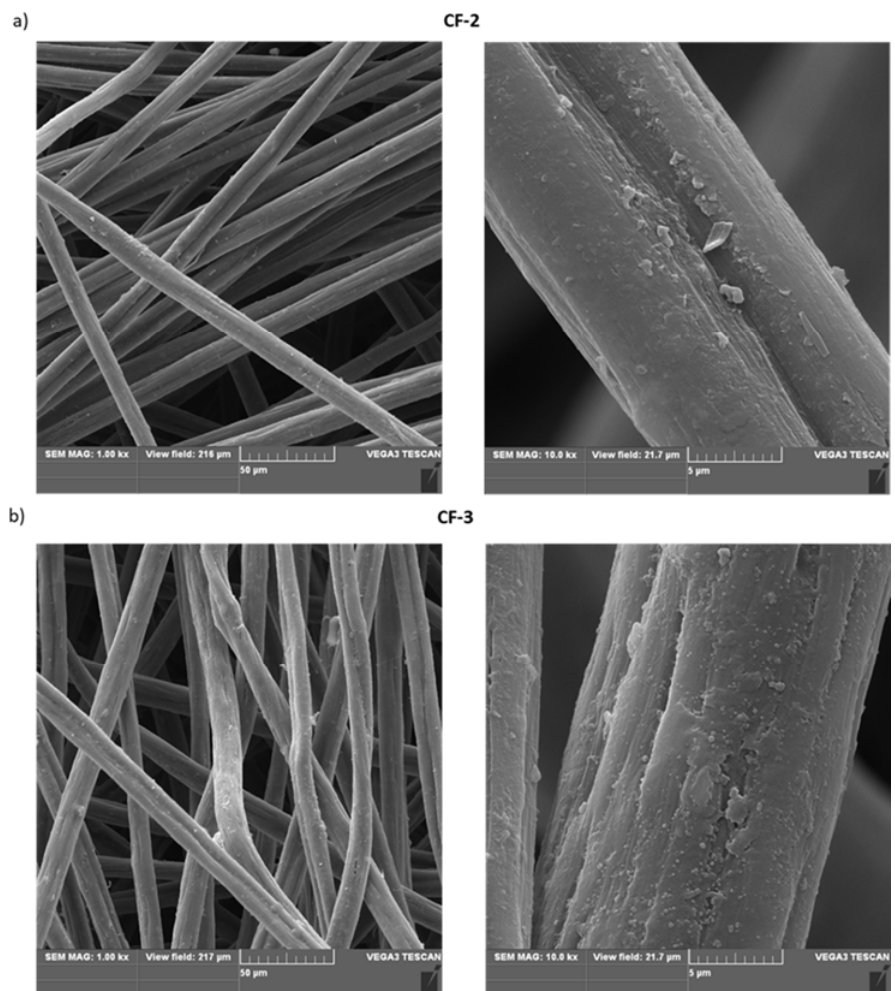
Figure 8. SEM images of: ( a ) modified carbon nonwoven fabric containing C 6 H 4 -CONH-CH 2 CH 2 - NH 2 on the surface ( CF-2 ); ( b ) modified carbon nonwoven fabric containing C 6 H 4 -CONH-CH 2 CH 2 - NH-DGR-Ac on the surface ( CF-3 ). Table 2. Summary of physicochemical measurements: contact angle (CA) and surface free energy (SFE) for carbon nonwovens unmodified (CF) and chemically modified ( CF-1c , CF-3 ). Water CA, Sample